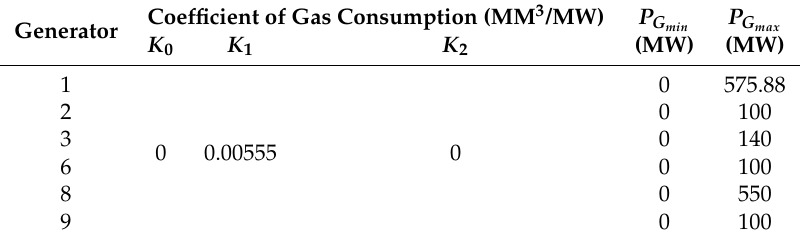
Table A1. Operation characteristics of the combined cycle power plants for Case 1.